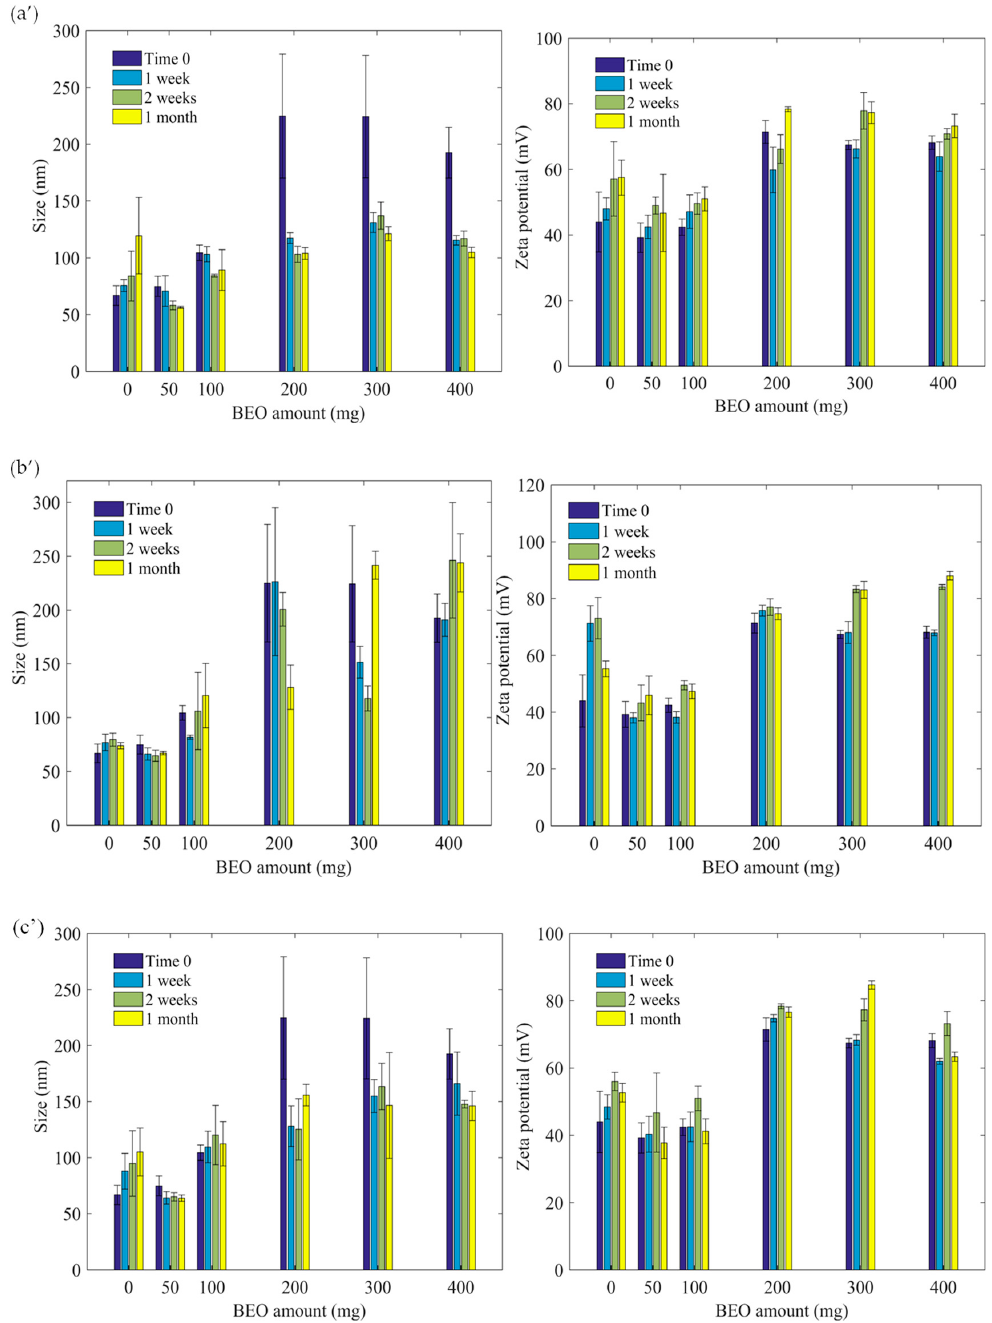
Figure 4. ( a’ ) Size and zeta potential at 25 ◦ C for bergamot essential oil, ( b’ ) 4 ◦ C, ( c’ ) 40 ◦